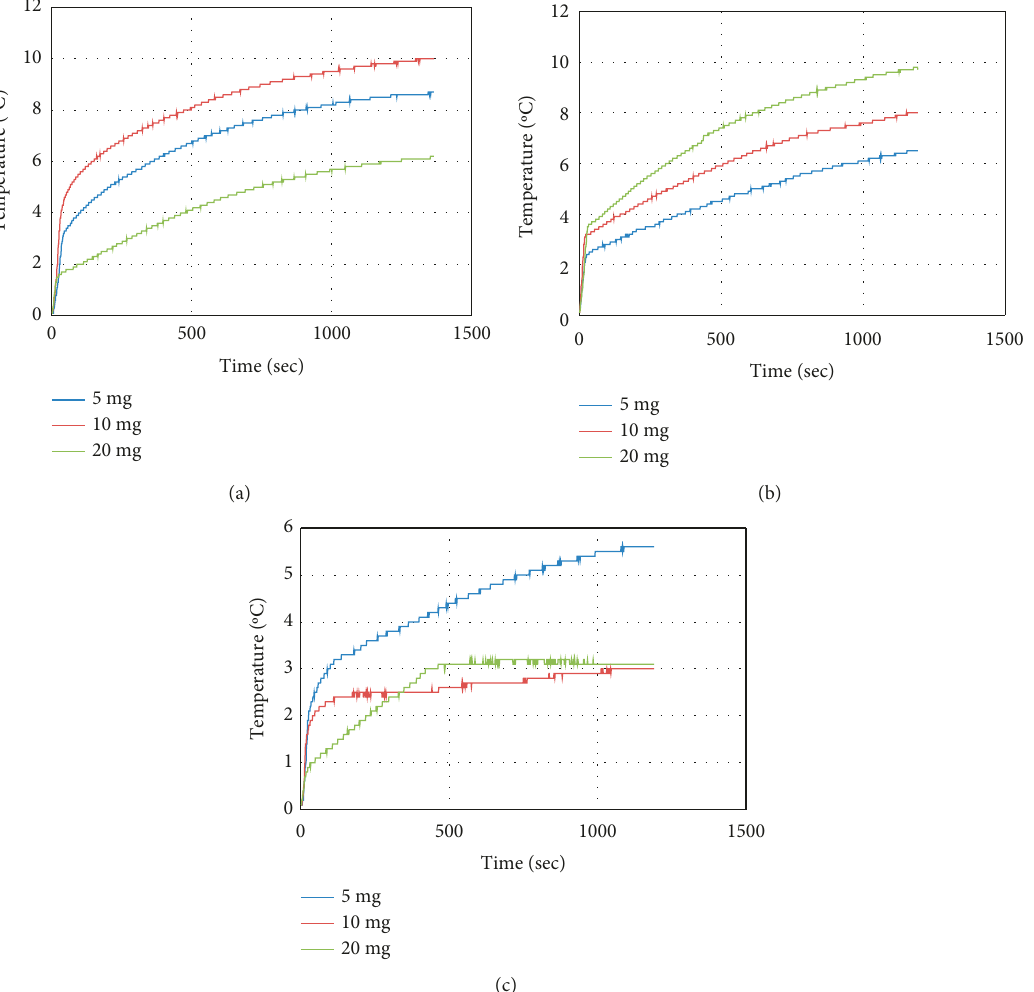
Figure 10: Hyperthermia heating efficiency of (a) NiFe 2 O 4 , (b) NiFe 2 O 4 @TiO 2 , and (c) NiFe 2 O 4 @TiO 2 @rGO core@shell